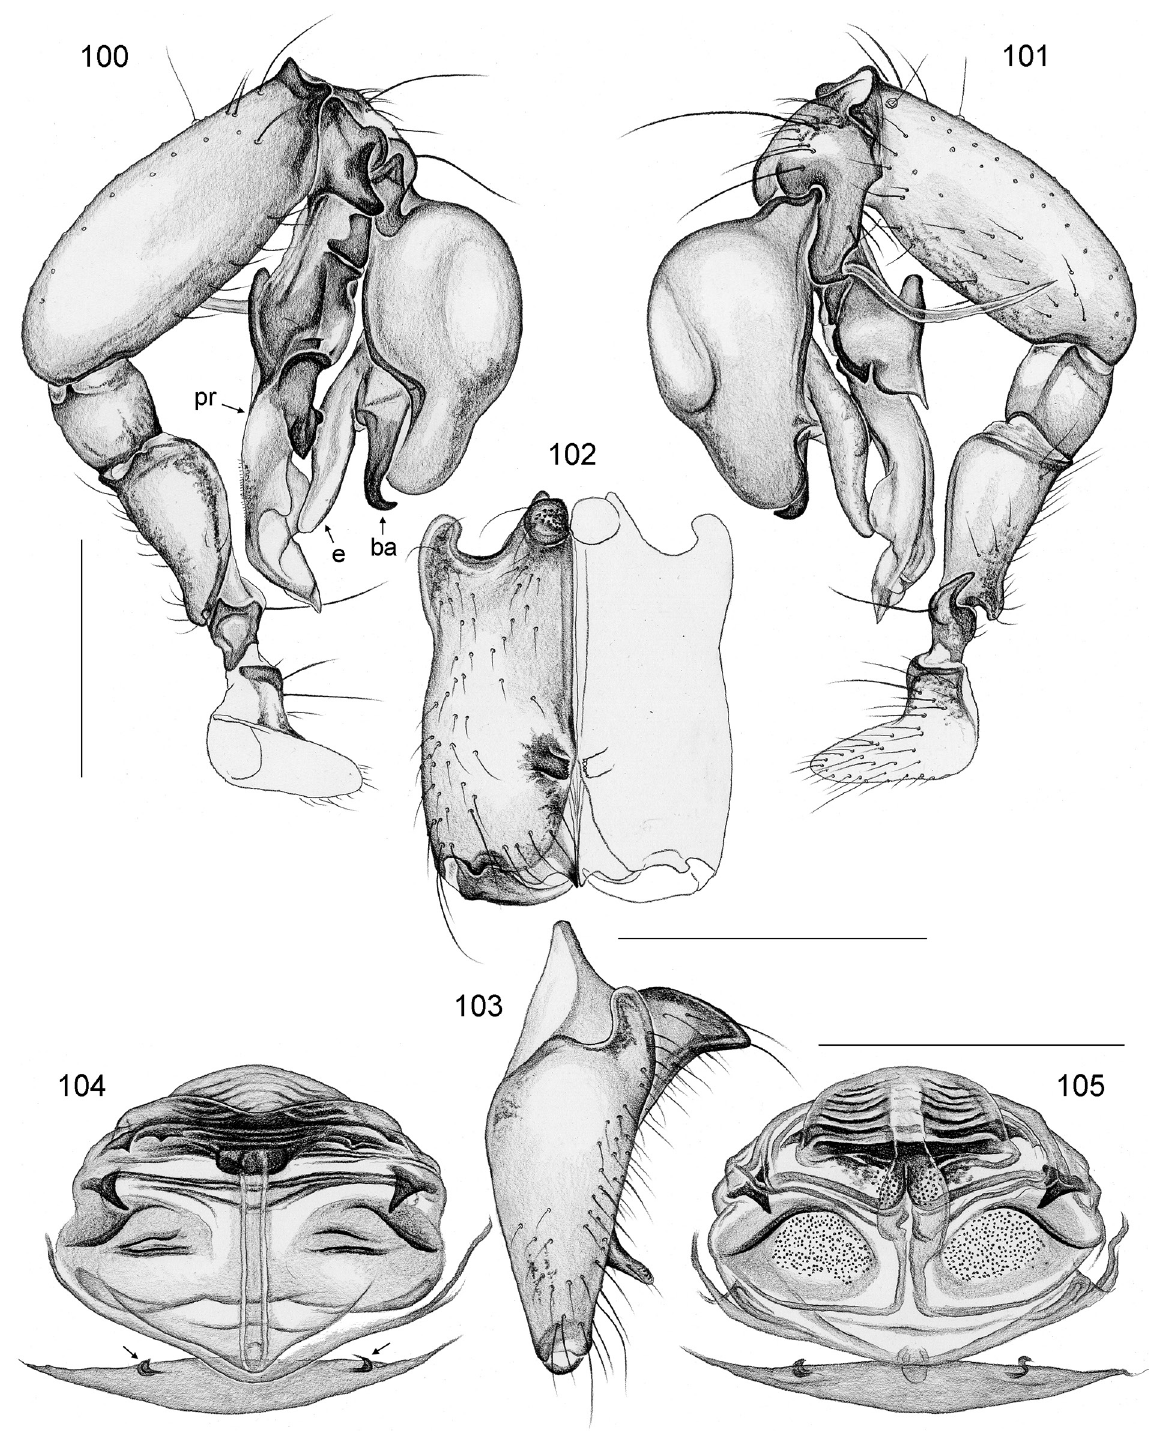
Figs 100-105. Spermophora ziama sp. nov. 100-101 . Left ♂ palp, prolateral and retrolateral views (ba = bulbal apophysis; e = embolus; pr = procursus). 102-103 . ♂ chelicerae, frontal and lateral views. 104-105 . Cleared ♀ genitalia, ventral and dorsal views. Arrows point at pockets in posterior epigynal plate. Scale lines: 100-101, 104-105 = 0.5 mm; 102-103 = 0.3